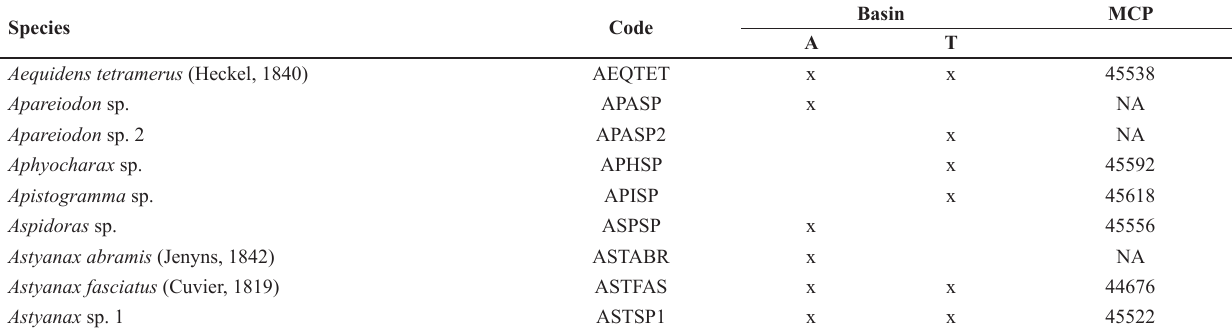
Table 2. Code and voucher number (MCP = Museu de Ciências e Tecnologia da Pontifícia Universidade Católica do Rio Grande do Sul) of species sampled in 25 headwater streams of Araguaia (A) and Tocantins (T) river basins. NA=not